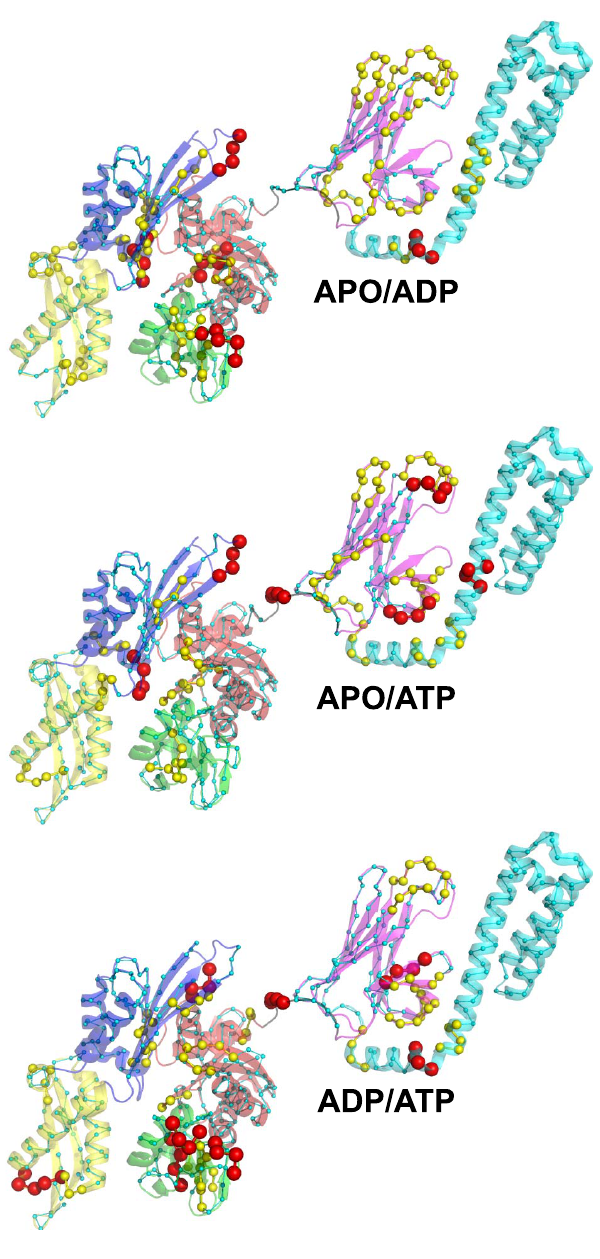
Figure 5. Analysis of 1-D FEPs of CGDAs c . Mapping of the dissimilarity index 1-H between the FEPs of APO/ADP (top panel), APO/ ATP (middle panel) and ADP/ATP (bottom panel) onto the structure of DnaK (PDB ID: 2KHO) [70]. Residues belonging to the CGDAs c which are strongly influenced ( 1-H . 0.7), significantly influenced (0.3 # 1-H , 0.7) and weakly influenced by the nucleotide ( 1-H # 0.3) are shown with large red, medium yellow and small cyan spheres, respectively. The color code of the protein structure is the same as in Fig. 1. These figures were prepared with PyMOL [http://www.pymol.org].